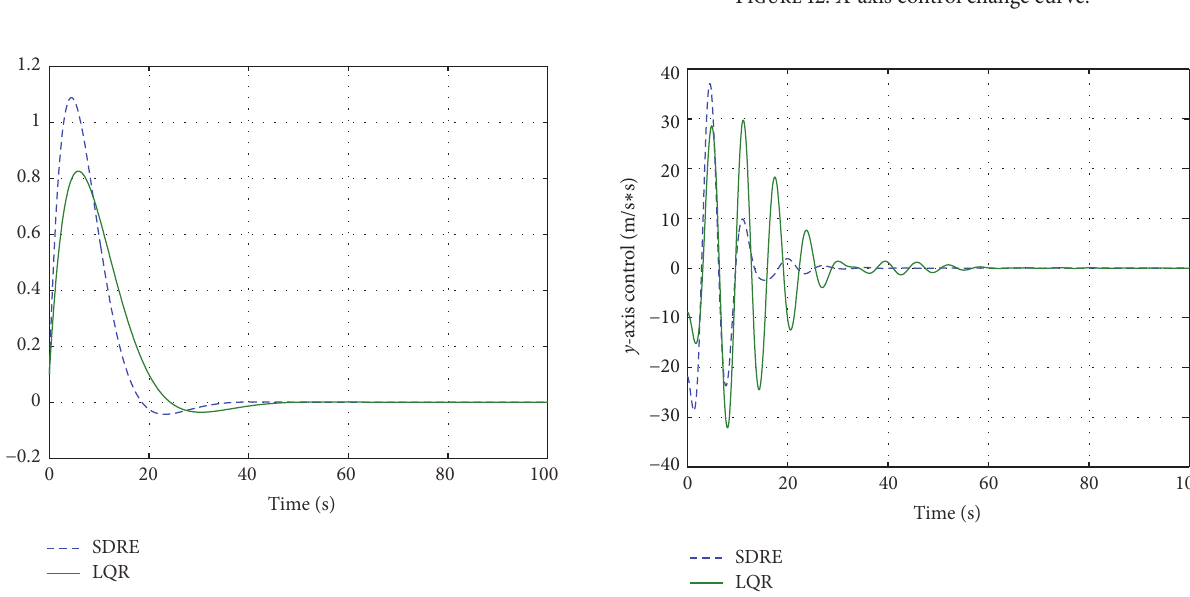
Figure 10: 𝑌 axis velocity error variation curve.